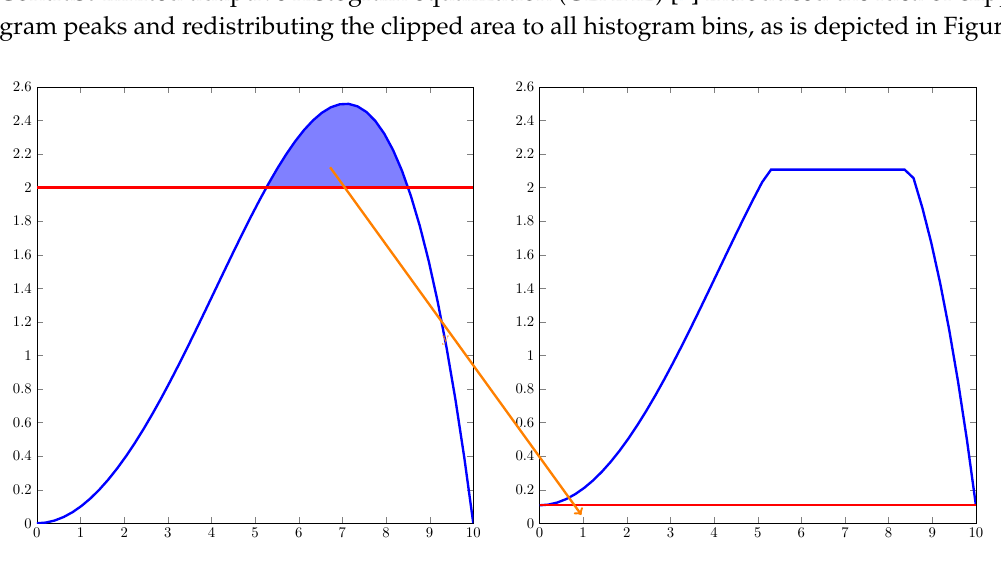
Figure 3. Local histograms might be clipped to reduce noise